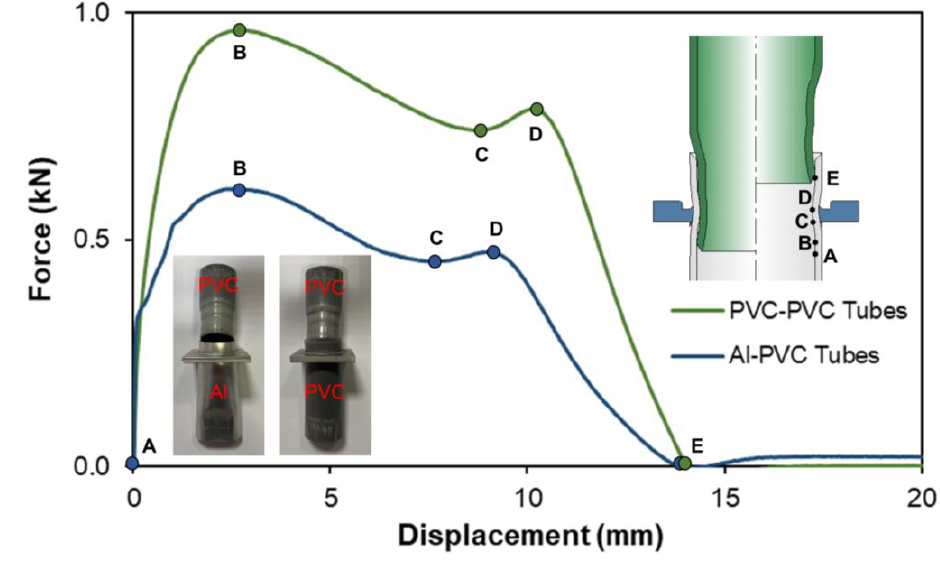
Figure 10. Experimental force–displacement evolutions for two PVC tubes as well as an upper tube of PVC and a lower tube of aluminum.